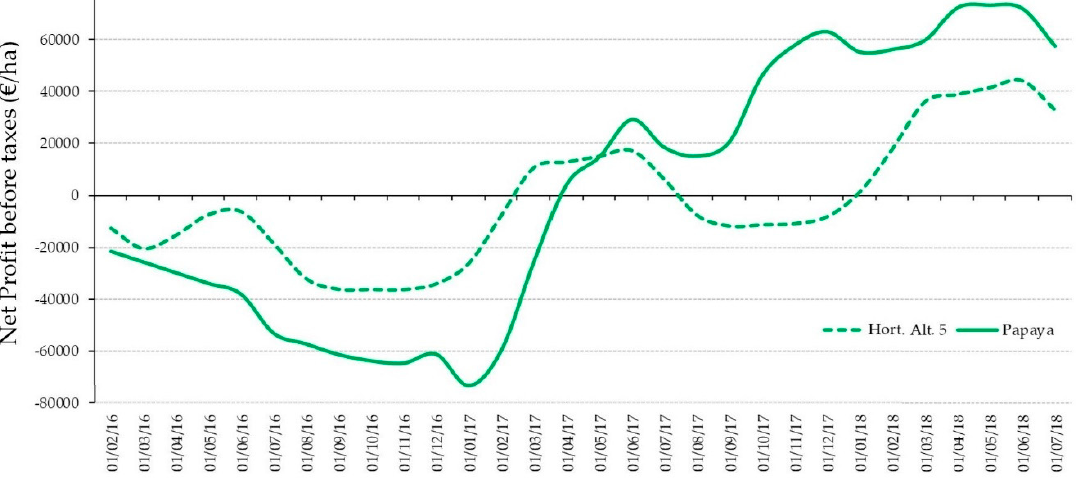
Figure 5. Monthly evolution of the accumulated Net Profit before taxes (NPbt) for Horticultural alternative 5 ( --- ) versus papaya cultivation ( — ) ( € / ha) during the trial period (February 2016 to July 2018). Own elaboration [ 17,30].